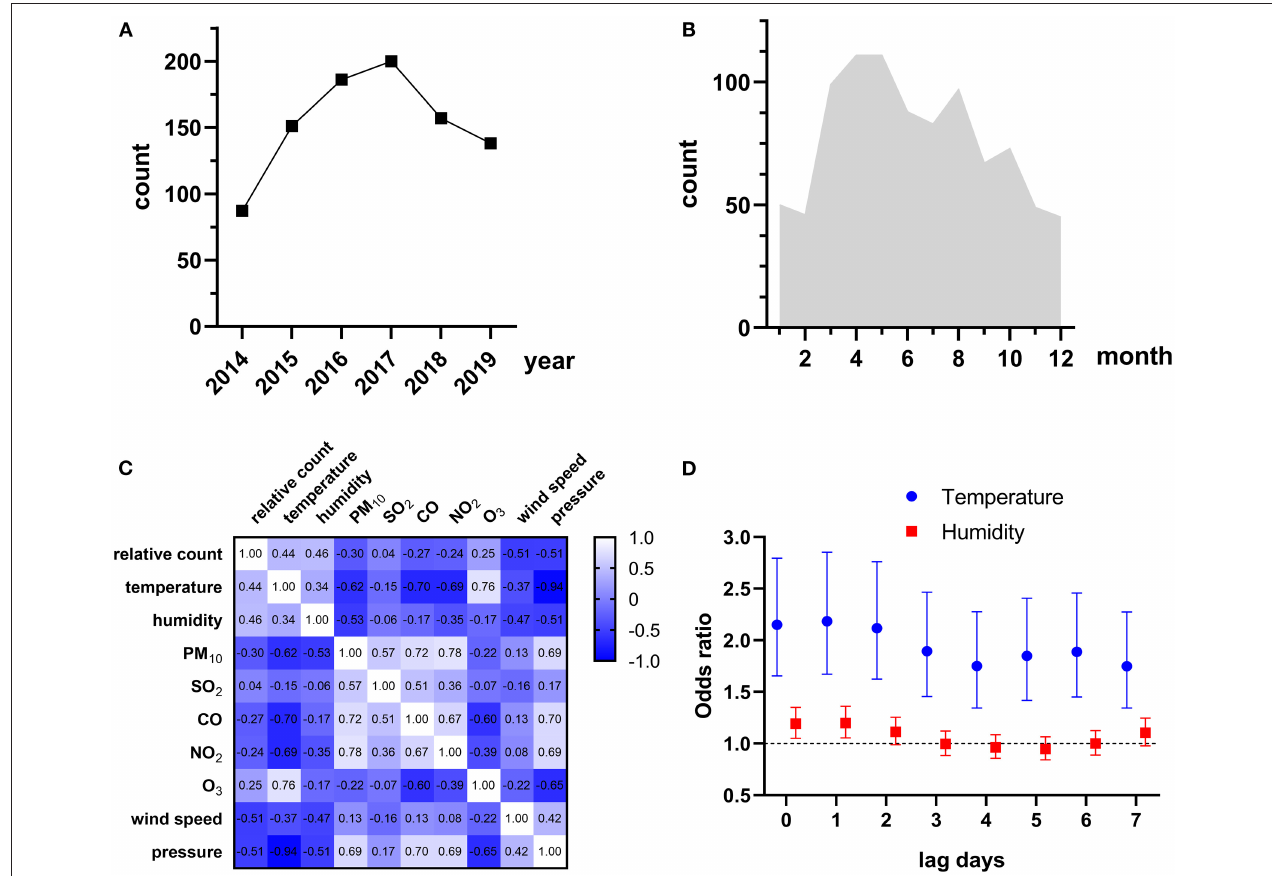
FIGURE 1 | (A) Yearly talaromycosis hospitalizations of HIV-infected patients during 2014–2019. (B) Average monthly talaromycosis hospitalizations of HIV-infected patients. (C) Spearman’s correlations between relative count of monthly talaromycosis hospitalizations and environmental variables. The correlation coefficient is shown in each cell. (D) Environmental variables significantly associated with talaromycosis hospitalizations.